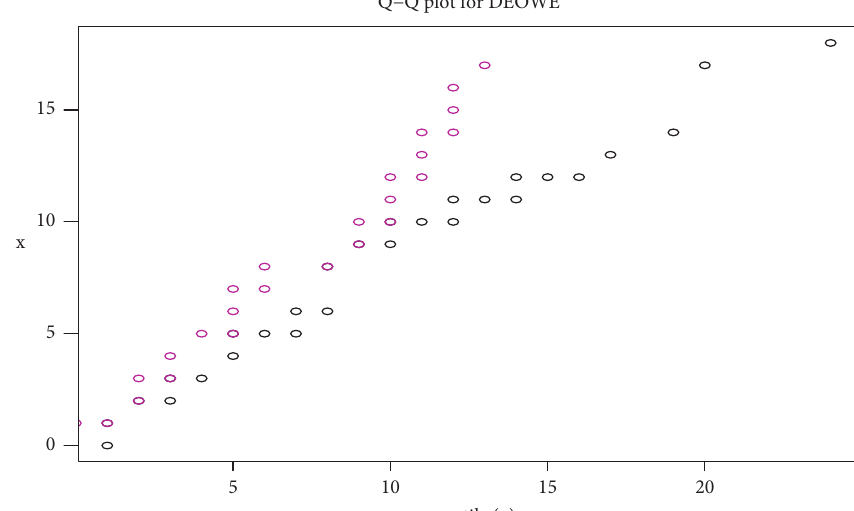
Figure 15: Graphical plots of the data and the quantile function as a function of x , where x is the number of deaths per day.